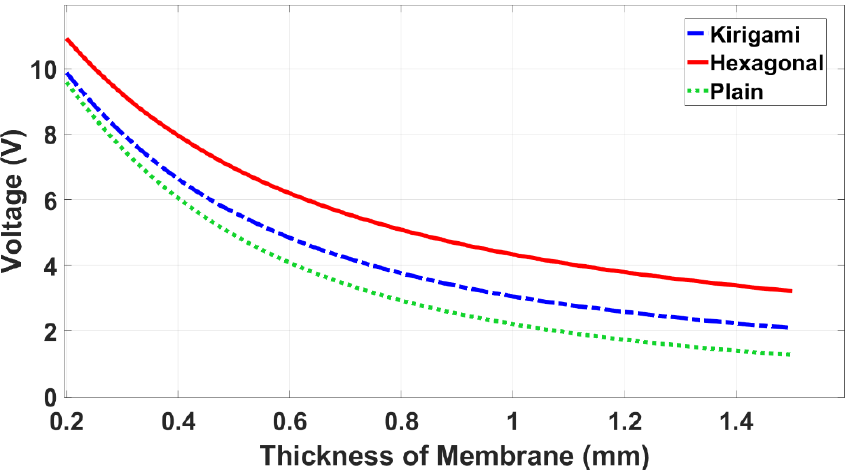
Figure 15. Simulated voltage output against the thickness of the membrane and